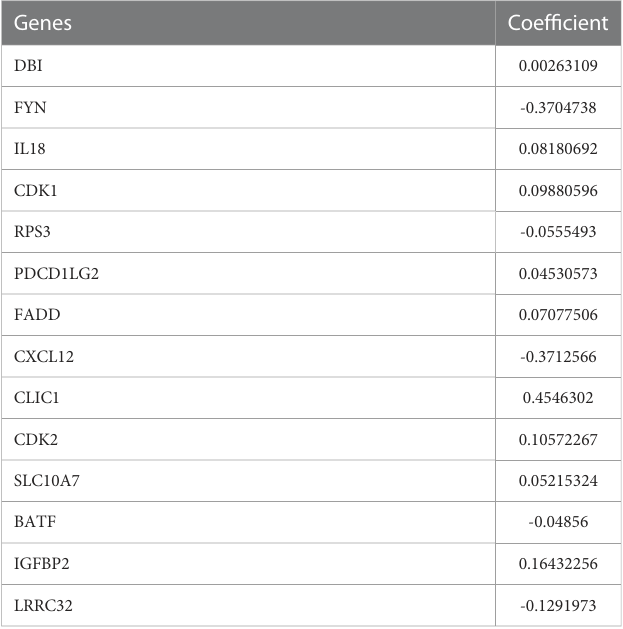
TABLE 2 The coef fi cient value of TRPs